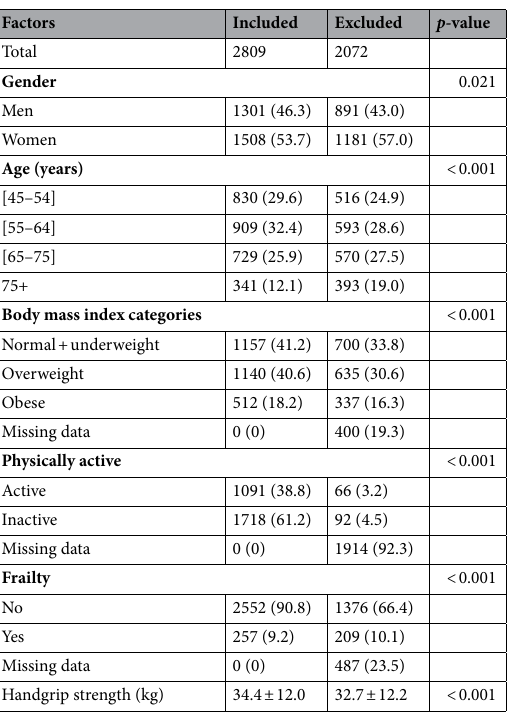
deviation. Between-group comparisons performed using chi-square and student’s